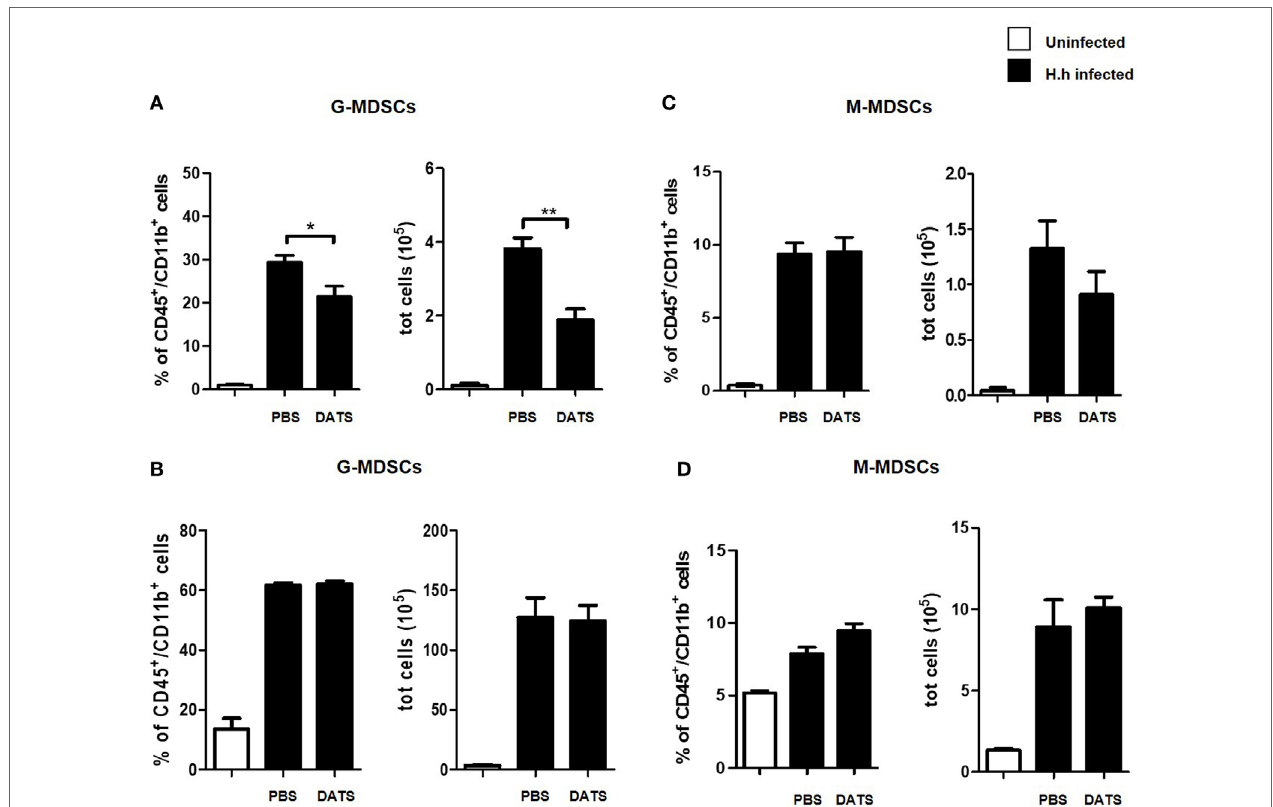
FigUre 6 | DATS inhibits G-MDSCs accumulation in the colon of Helicobacter hepaticus ( Hh )-infected mice. Leukocytes were isolated from the colon and the spleen of 129SvEv Rag2 − / − uninfected or Hh -infected 6 weeks post-infection. Infected mice were treated with DATS or vehicle (PBS). G-MDSCs and M-MDSCs frequencies and absolute number were assessed by flow cytometry in colon (a,c) and in spleen (B,D) . G-MDSCs frequency and number was reduced in the colon following treatment with DATS. Data are shown as mean ± SEM ( n = 5 per group) (* P < 0.05, ** P < 0.01, DATS vs.